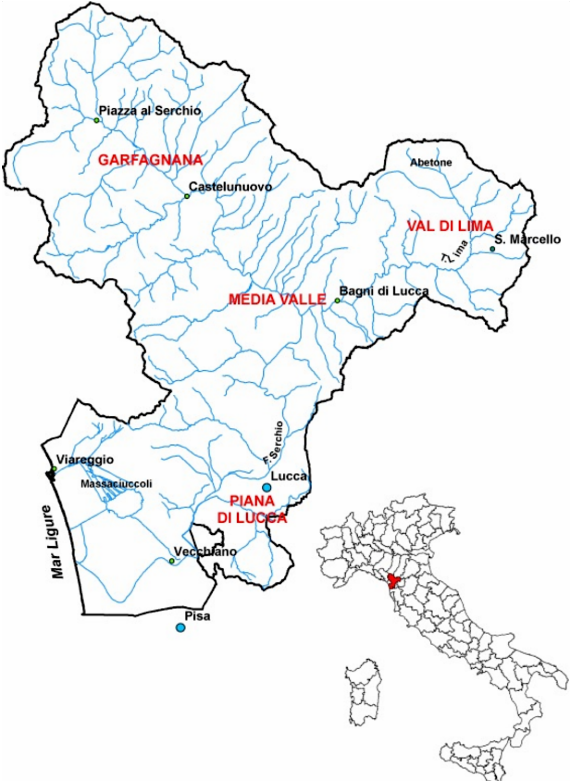
Figure 1. Overview of Serchio basin.